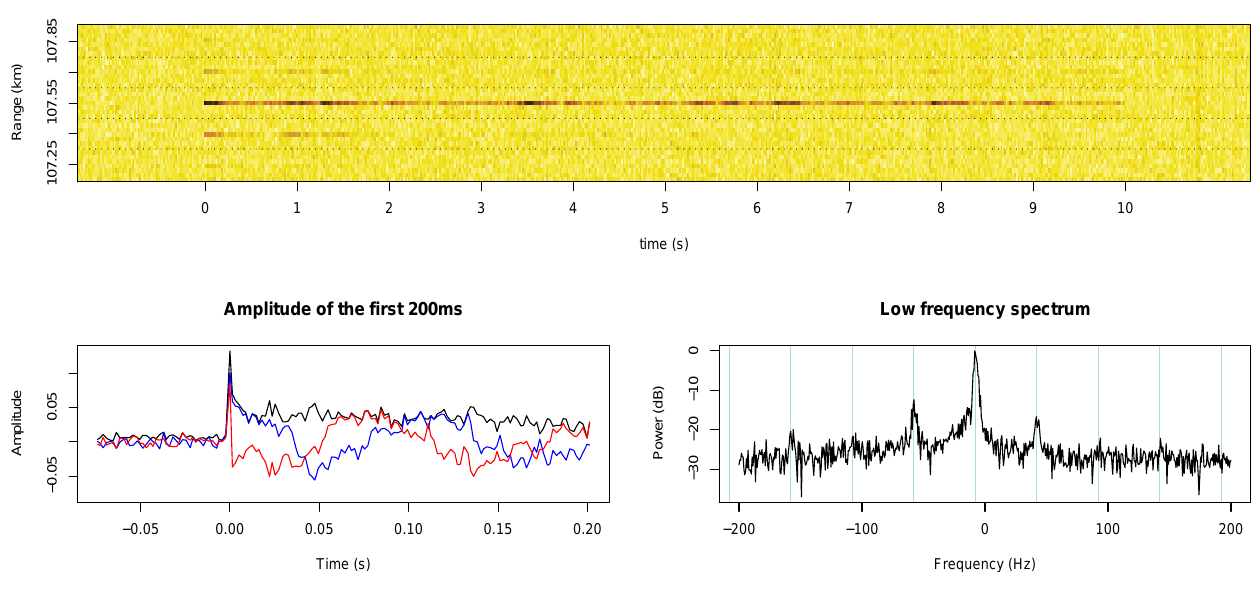
Fig. 6. Backscatter amplitude estimate of the sporadic E-region heating effect. The time is relative to the start of the 10 s O-mode heater on period. The figure above shows the modulus of the seven ± 20kHz Fourier series coefficients c j,k used to estimate the amplitude of each range gate during the 150 µ s that the transmission pulse passes each range. The heating effect is mostly concentrated in only one range gate, with slight hints of power on the neighboring range gates, which cannot be explained by a model with only one range gate. The figure on the lower left depicts the amplitude behaviour of the first 200ms of heating at 107 . 55km. Blue is real and red is the imaginary part of the signal, the black line is the modulus of amplitude. The first echo is stronger and at a different phase than the rest of the backscattered waveform. On the lower right is the low frequency spectrum of the reflection amplitude from 107 . 55km estimated over the whole 10s heater on period. The main Doppler shift is centered at around − 8Hz. The blue vertical lines depict 50Hz harmonics shifted by − 8Hz. It is unclear why the 50Hz harmonics are in the received backscatter signal – but it does not seem to be caused by the EISCAT VHF TX or RX receive path. Possibilities include heater modulation or a direct modulation by ground based power transmission